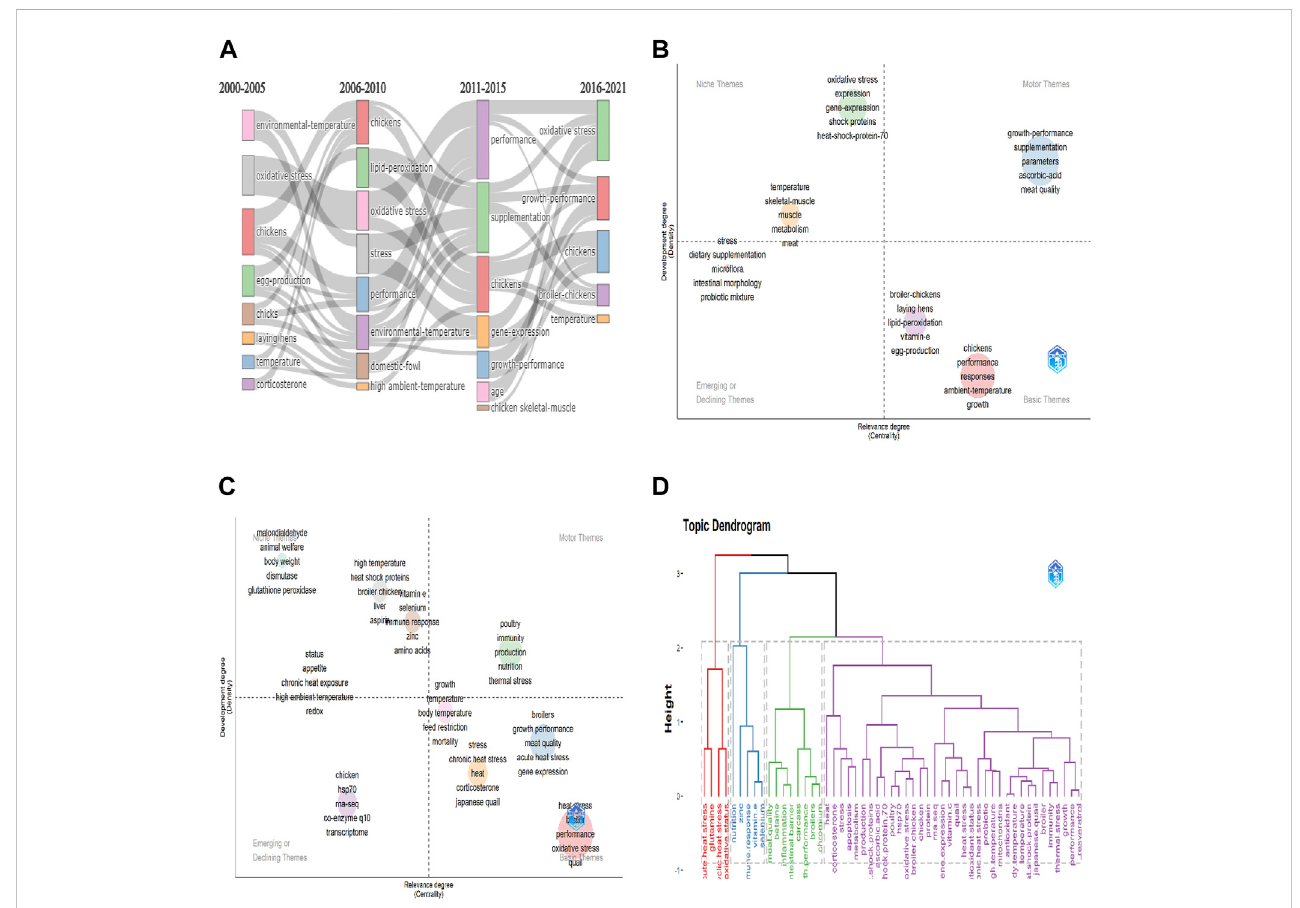
FIGURE 10 Keywords analysis for global research terms on heat stress in poultry. (A) Thematic evolution of Keyword Plus from 2000 to 2021. (B) Thematic map analysis of Keyword Plus (C) Thematic map analysis of authors keywords. (D) Topic dendrogram using multiple correspondence analysis of authors keywords to show the hierarchical relationship between